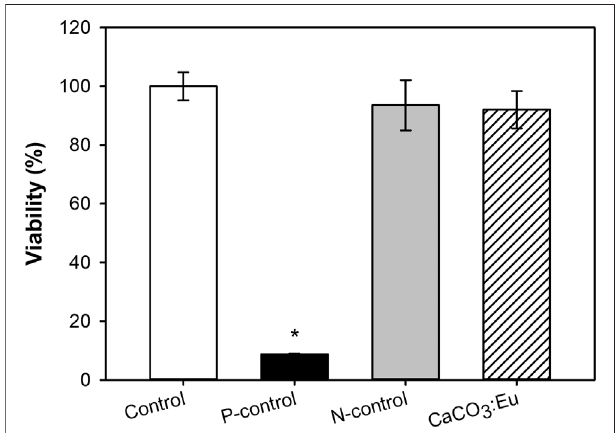
FIGURE 7 | The evaluation of cell viability of synthesized CaCO 3 : Eu. * p <